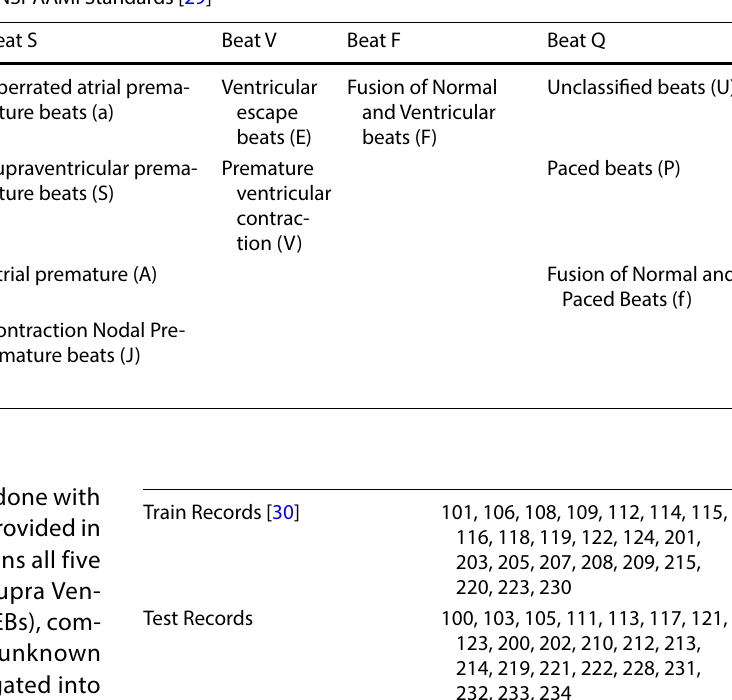
types of beats which are Normal beats (N), Supra Ven- tricular Ectopic (SVEBs), Ventricular Ectopic (VEBs), com- beats (Q) [14]. The whole MIT-BIH AD is segregated into Train dataset (DS1) and Validation or test dataset (DS2) tains information from 22 records [16].